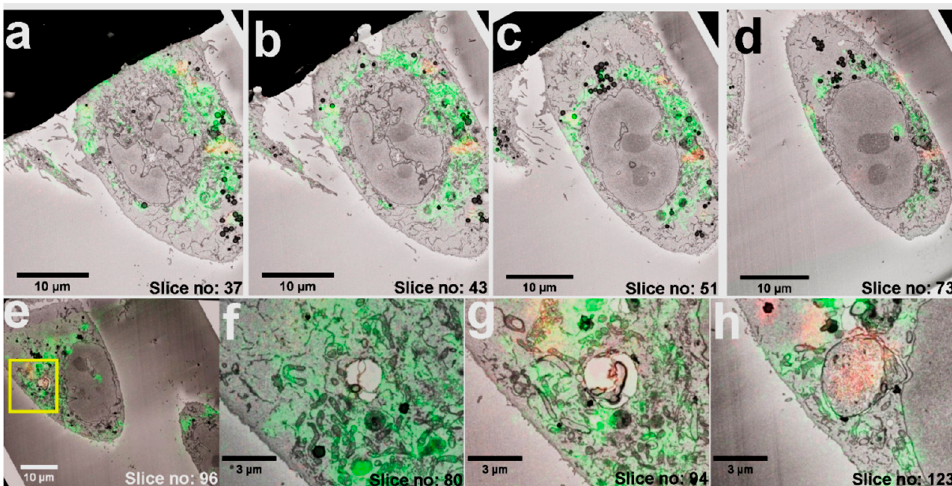
Figure 4. Volume-CLEM of living cells. ( a – d ) CLEM images of multiple planes in increasing z -axis. ( e ) ROI selected in CLEM image to demonstrate the correlation of LM over EM. ( f ) In slice no: 80, a single high-resolution image shows numerous mitochondria (green) and an empty vesicle. ( g ) In slice no: 94, FNDs (red), mitochondria (green), and a vesicle can be seen. ( h ) In slice no: 123, a vesicle filled with FNDs (red), and fewer mitochondria (green) can be seen. FNDs in the EM image are the dark dots inside the vesicle.